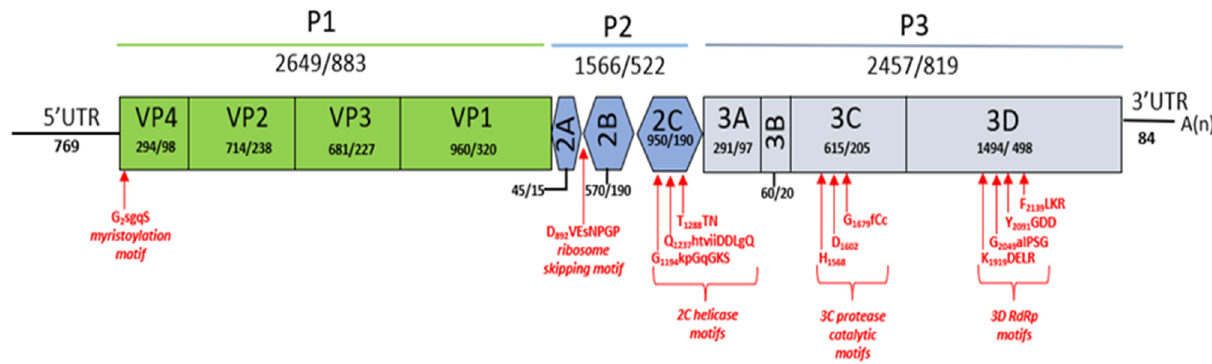
Figure 2. Genome organisation of deer/bopivirus described in this study. The gene boxes corresponding to the P1 (viral capsid proteins), P2, and P3 (non-structural proteins) are highlighted differently. The nucleotide and amino acid lengths of the corresponding genomic regions are shown in each gene box. A red arrow indicates relevant protein motifs and their position within the polyprotein.